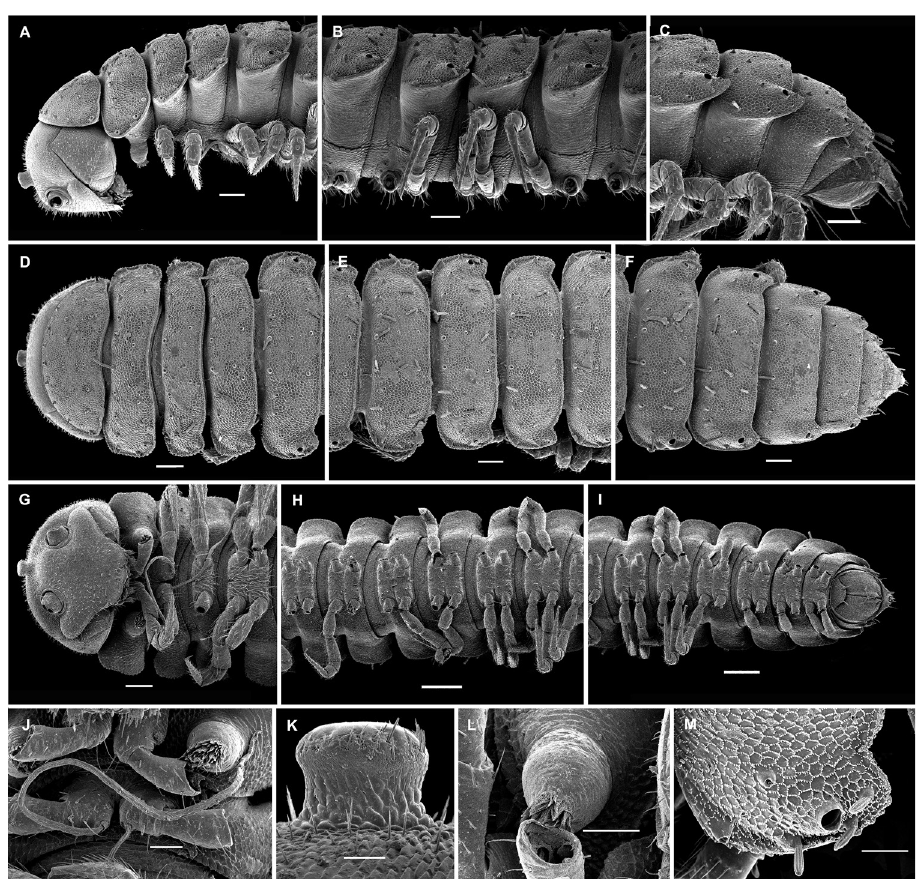
Figure 21. Hemisphaeroparia subfalcata sp. n., SEM micrographs of ♂ paratype A, D, G anterior part of body, lateral, dorsal and ventral views, respectively B, E, H midbody segments, lateral, dorsal and ventral views, respectively C, F, I posterior part of body, lateral, dorsal and ventral views, respectively J, L spiracle lateral to coxa 2, lateral and sublateral views, respectively K epicranial tubercle, dorsal view M midbody paratergum, lateral view. Scale bars: 0.2 mm ( H, I ), 0.1 mm ( A–G ), 0.05 mm ( J, M ), 0.02 mm ( K, L